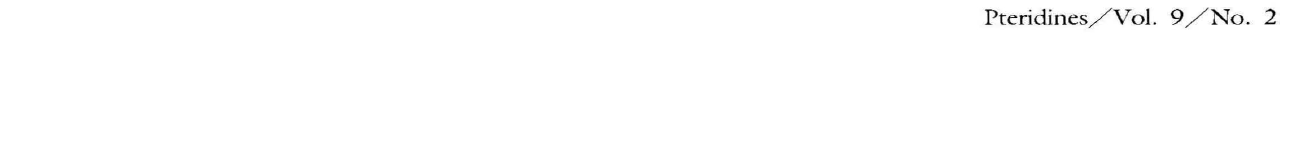
Table 2 points out the changes of fluorescence at 360 nm (excitation) and 420 nm (emission ) of rat liver homogenate as well as homogenate at the time of addition and after 8 hours incubation